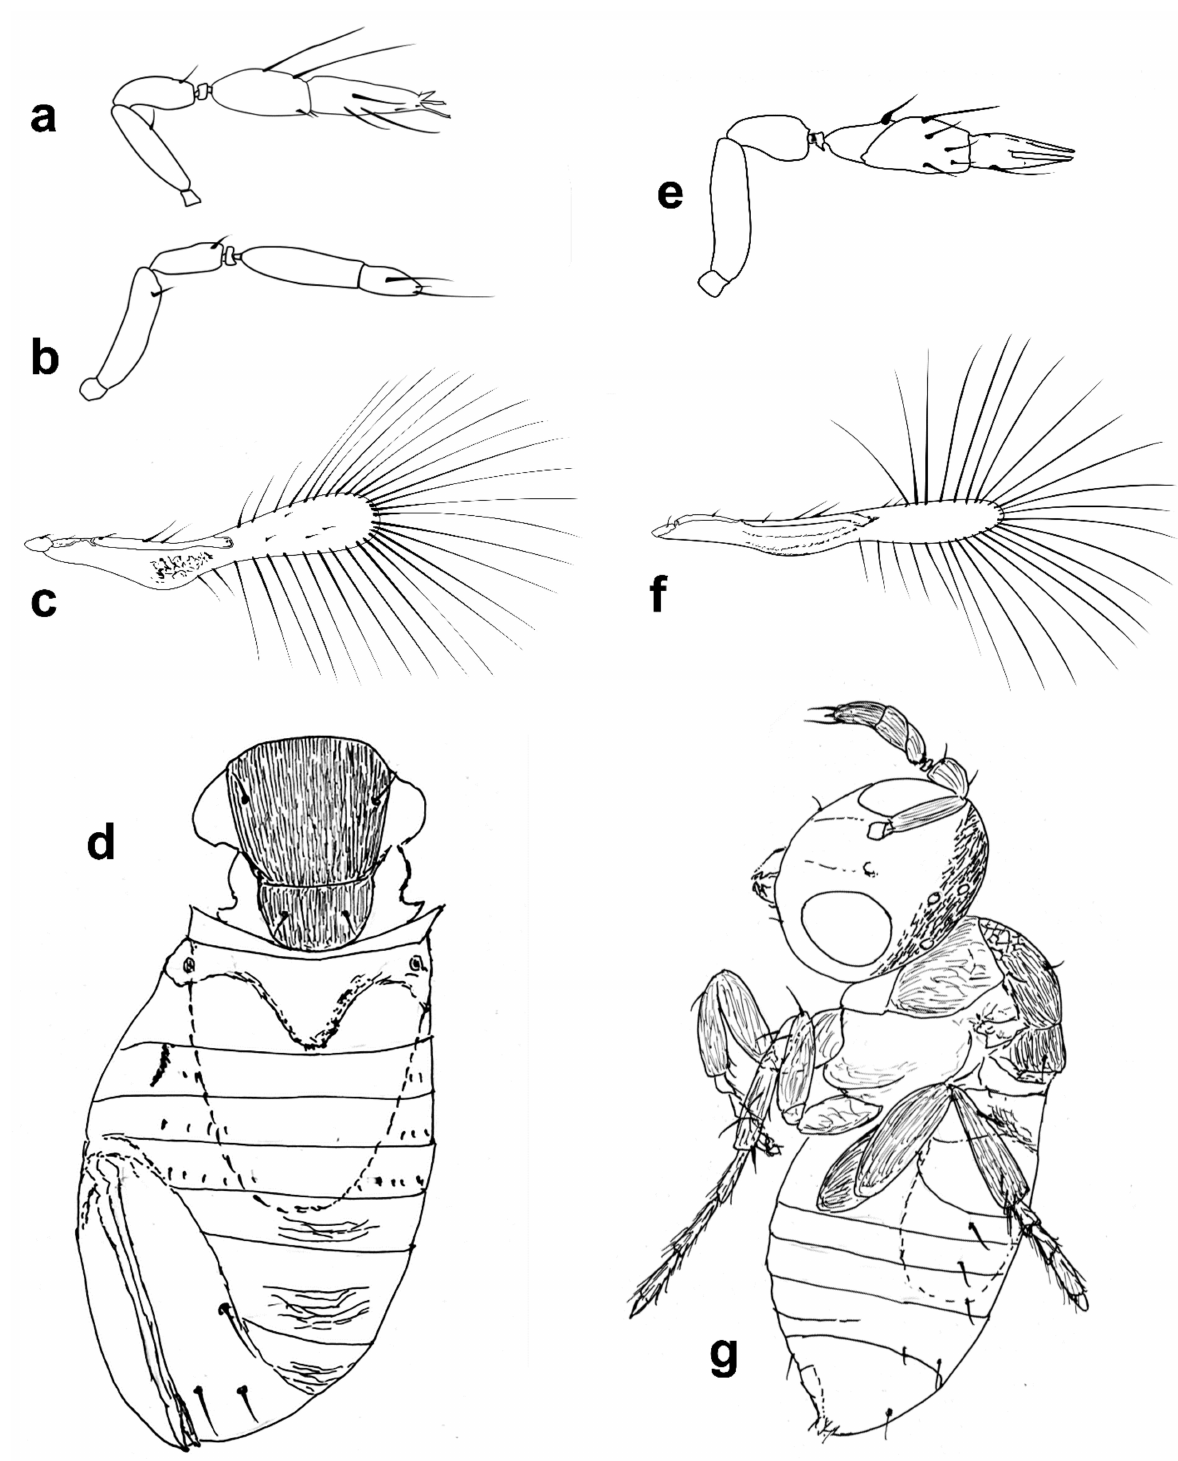
Figure 3. Line drawings of Megaphragma species: ( a ) M. caribea , female antenna (Paratype); ( b ) M. caribea , male antenna (Paratype); ( c ) M. caribea , female fore wing (Paratype); ( d ) M. deflectum , female body dorsal (Holotype); ( e ) M. deflectum , female antenna (Holotype); ( f ) M. deflectum , female fore wing (Holotype); ( g ) M. ghesquierei , male body lateral